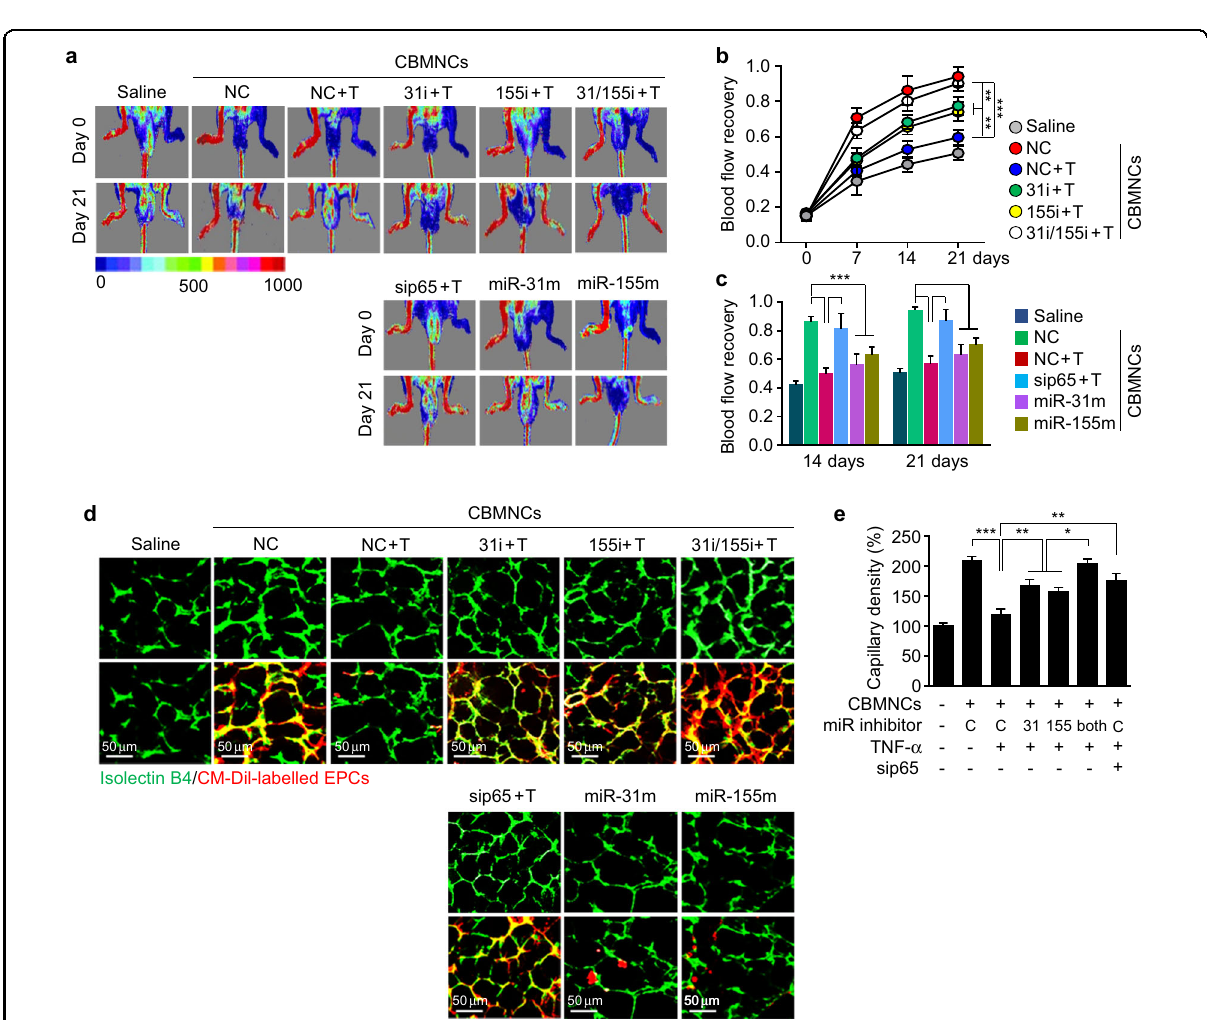
Fig. 8 EPCs differentiated from CBMNCs that were treated with TNF- α or miR-31/155 mimics lose their capability to improve therapeutic neovascularization in mouse ischemic hindlimbs. CBMNCs were transfected with negative control (NC or C), NF- κ B p65 siRNA (sip65), miR-31 inhibitor (miR-31i), miR-155 inhibitor (155i), miR-31 mimic (miR-31m), or miR-155 mimic (miR-155m) and differentiated into EPCs in fresh media with or without TNF- α (T). Putative EPCs were intramuscularly transplanted into the ischemic hindlimbs of athymic nude mice. a Representative laser- Doppler perfusion image of mouse hindlimbs at days 0 and 21 after hindlimb ischemia . b , c Time course of computer-assisted analysis of the ratio of blood fl ow between ischemic and nonischemic contralateral limbs ( n = 5). d Representative images of capillaries (FITC-isolectin B4, green) and incorporated EPCs (yellow and red) in transverse sections of skeletal muscles from ischemic mouse hindlimbs that received CM-Dil-labeled putative EPCs. e Quantitative analysis of capillary density ( n = 5). * P < 0.05, ** P < 0.01, and *** P <